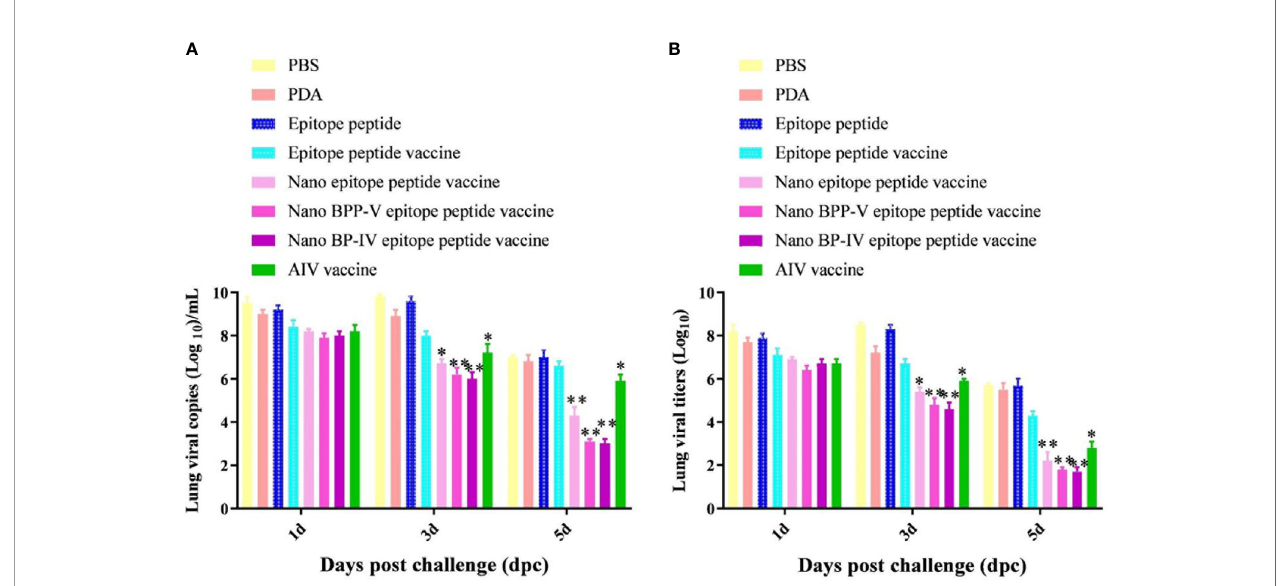
FIGURE 8 | Detection of viral titres in the lungs of H9N2 AIV-challenged mice by RT-PCR and TCID 50 . Mice were challenged on day 21 after immunization, and their lungs were collected on days 1, 3 and 5 after the challenge. (A, B) show the genomic copy numbers and titres of H9N2 AIV in the mouse lungs on days 1, 3 and 5 post-challenge, respectively. The data are presented as the means ± SD. * P < 0.05 and ** P < 0.01, compared with the epitope peptide vaccine